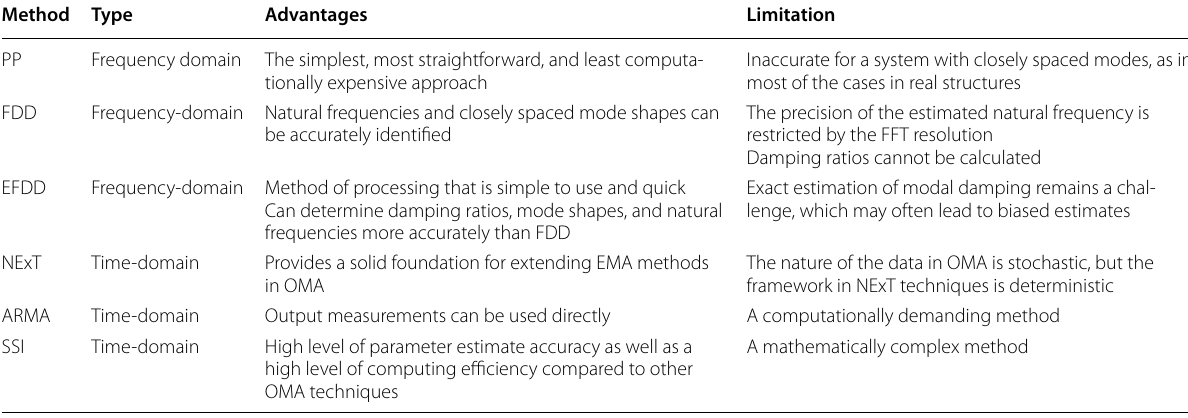
Table 5 Summary of available OMA techniques Method